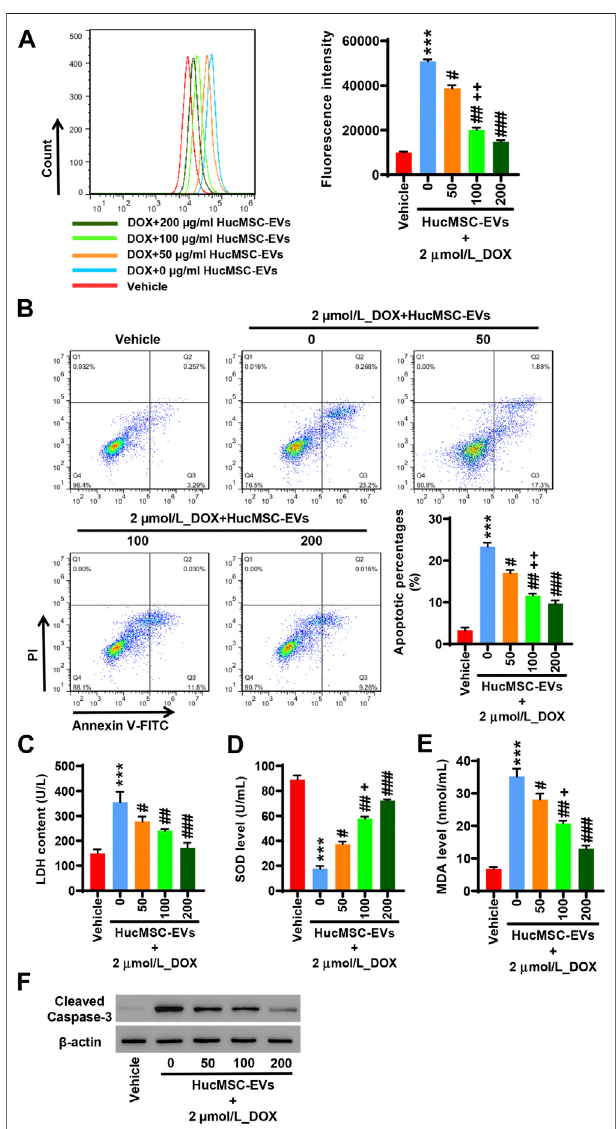
FIGURE 2 | HucMSC-EVs inhibit DOX-induced oxidative stress and apoptosis. AC16 cells were treated with 2 µmol/L DOX and HucMSC-EVs at different concentrations (0, 50, 100, and 200 μ g/ml) for 24 h. (A) ROS levels were measured by fl ow cytometry. (B) The percentages of apoptotic cells were assessed by fl ow cytometry. Quadrant 1 represented dead cells. Quadrant 2 represented late apoptotic cells. Quadrant 3 represented early apoptotic cells. Quadrant 4 represented normal cells. (C – E) The levels ofLDH (C) , SOD (D) , and MDA (E) were measured with biochemistry methods. (F) Western blot analysis of cleaved-caspase-3. *** p < 0.001 vs. vehicle, # p < 0.05, ## p < 0.01, ### p < 0.001 vs. 2 μ mol/L_DOX + 0 μ